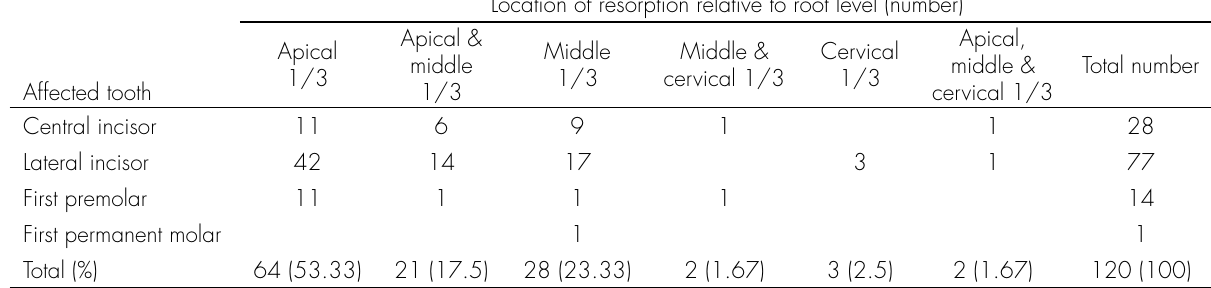
Table III. Distribution of resorption lesions relative to root